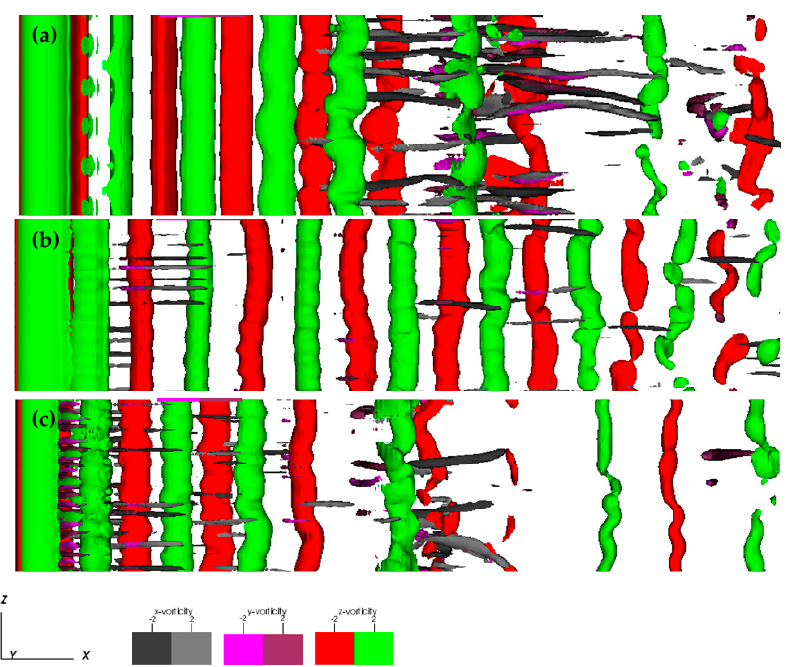
Figure 16. Counter-clockwise cylinder oscillation: Instantaneous vorticity isosurfaces (top view) for F = 1.1 and ( a ) Ay/D = 0.20, ( b ), Ay/D = 0.30, ( c ) Ay/D = 0.40.